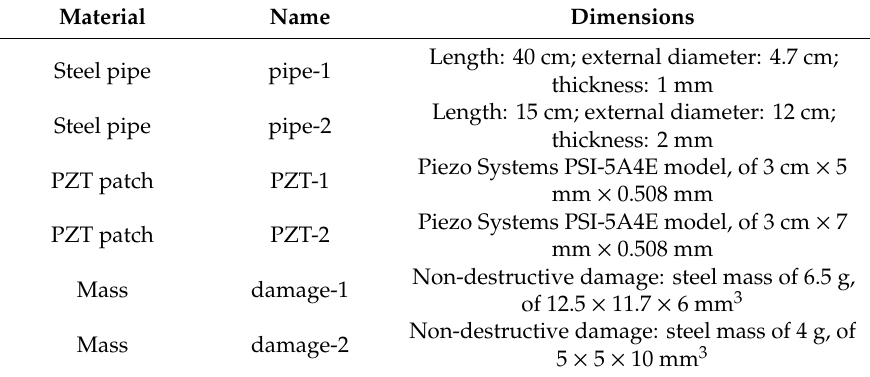
Table 1. Types of materials and dimensions of the structures, PZTs, and damage.